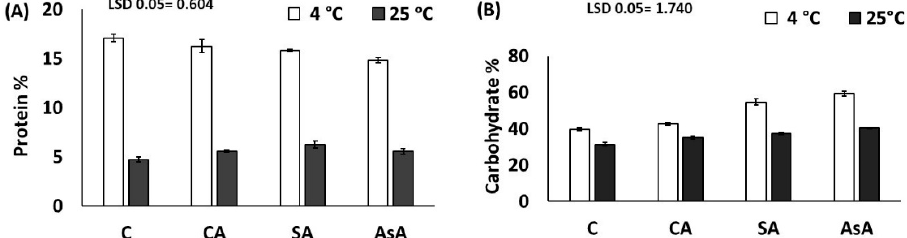
Figure 9. Effects of bio-stimulants B, control (C), citric acid (CA), salicylic acid (SA) and ascorbic acid (AsA) and storage temperature T (4 °C and 25 °C) on protein % (A) and carbohydrate % ( B ) of okra pods stored for 12 days. Error bars are the ±SD of the means of three biological replicates. LSD values ( p ≤ 0.05) for protein % ( A ): B = 0.43 and T = 0.30. LSD values ( p ≤ 0.005) for carbohydrate % ( B ) B = 1.19 and T = 0.844. LSD for B ×T is presented on the figure.